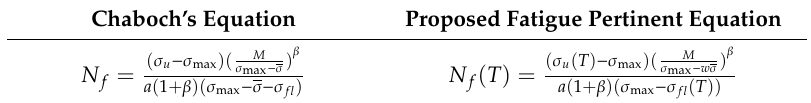
Table 4. A comparison between Chaboch’s fatigue equation and the improved fatigue equation. Chaboch’s Equation Proposed Fatigue Pertinent